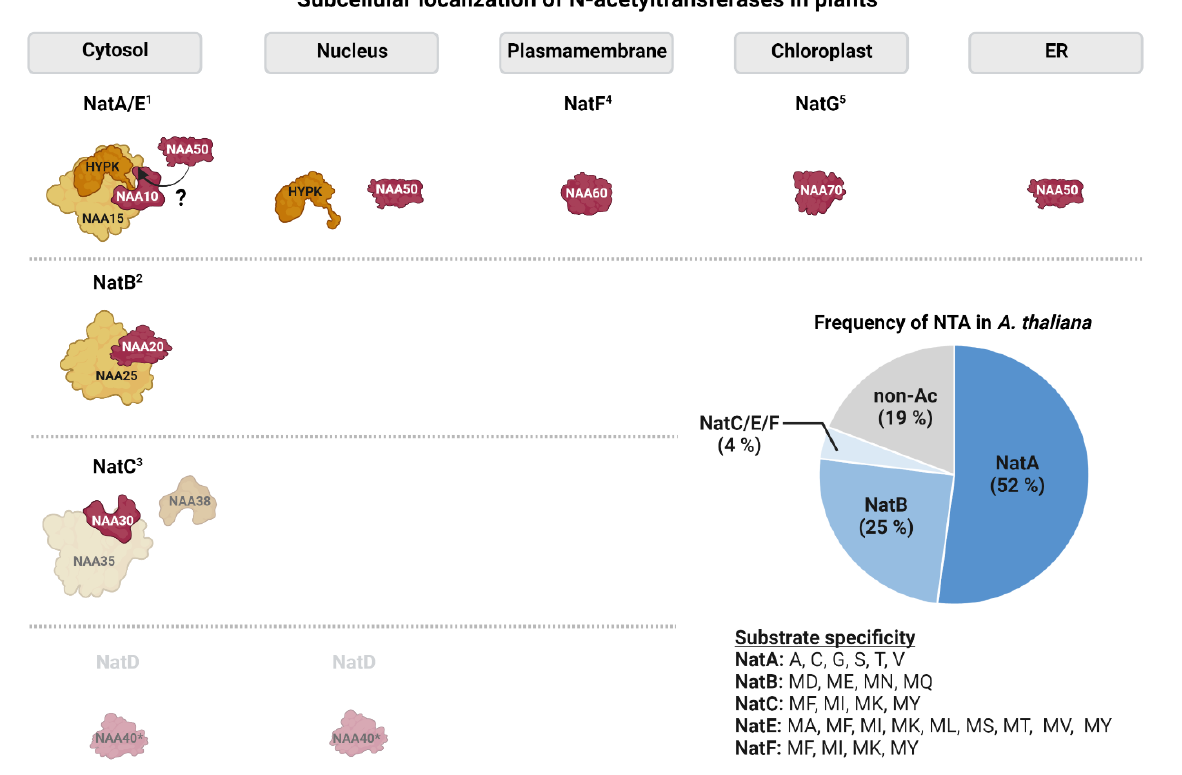
Figure 3 . Subcellular localization and substrate specificity of N-acetyltransferases in the model plant Arabidopsis thaliana . Catalytic subunits are schematically represented in red, whereas auxiliary subunits are depicted in orange. Subunits for which only predictions of subcellular localization are available are shown in lighter colors. From the plastid Nat family only NatG is shown for simplicity ( 1 : [20,44,50–52]; 2 : [47]; 3 : [45]; 4 : [46]; 5 : [21,22], ?: debated in Arabidopsis). The pie chart shows the relative contribution of the individual acetyltransferases to the plant acetylome. Estimates are based on experimental data where acetyltransferases were assigned to acetylated N-termini based on their substrate specificity [20,53] .